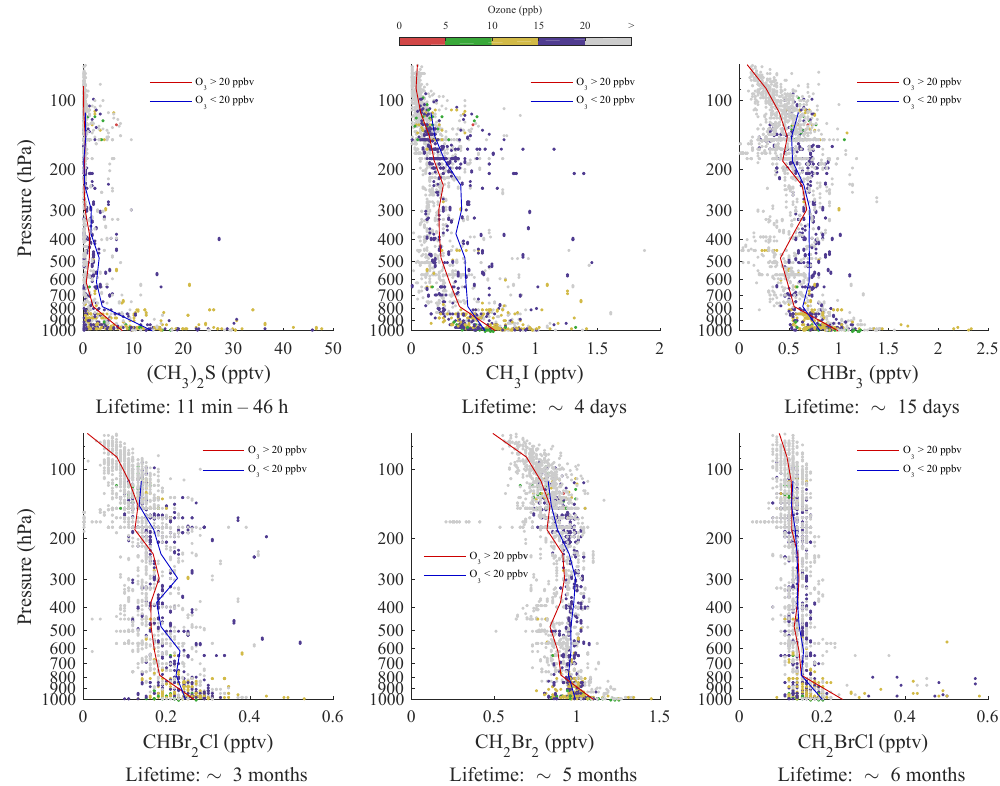
Figure 21. Panel plot of six compounds measured by the whole air samplers aboard the three aircraft. The red line indicates the average profile of measurements taken where ozone was above 20ppbv, and the blue line is the average profile for ozone below